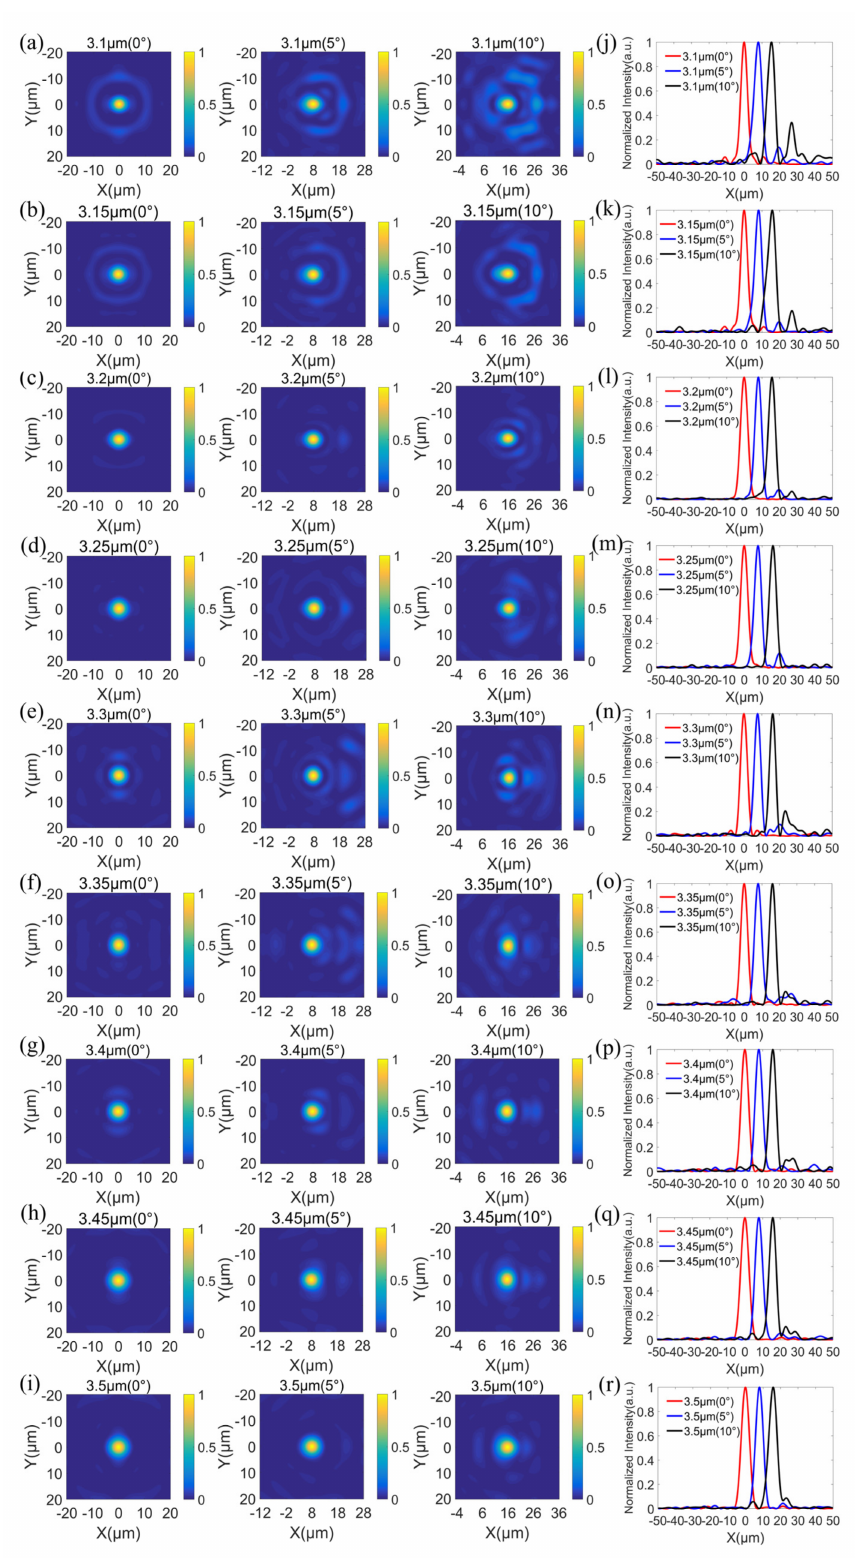
Figure 8. Focusing performance of the doublet metalens. ( a – i ) Simulated intensity profiles in the xy-plane at a fixed position of z = 120 µ m, i.e., the predesigned focal plane, at wavelengths from 3.1 to 3.5 µ m with incident angles of 0 ◦ , 5 ◦ , and 10 ◦ , respectively. ( j – r ) Simulated intensity distributions along the X direction of the focal planes at wavelengths from 3.1 to 3.5 µ m with incident angles of 0 ◦ (red), 5 ◦ (blue), and 10 ◦ (black),